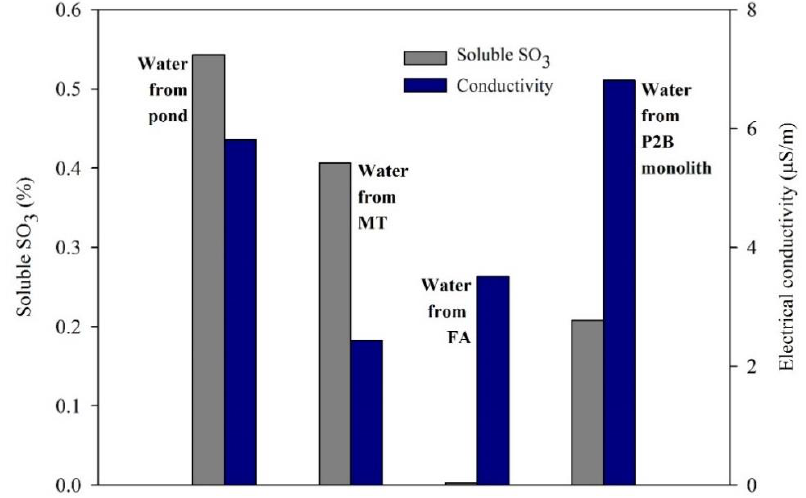
Figure 1. Comparison of the soluble SO 3 and electrical conductivity measured in the water from the mine ponds, in the water where the original MT and FA were submerged for 28 days, and in the water where a P2B monolith was submerged for 28